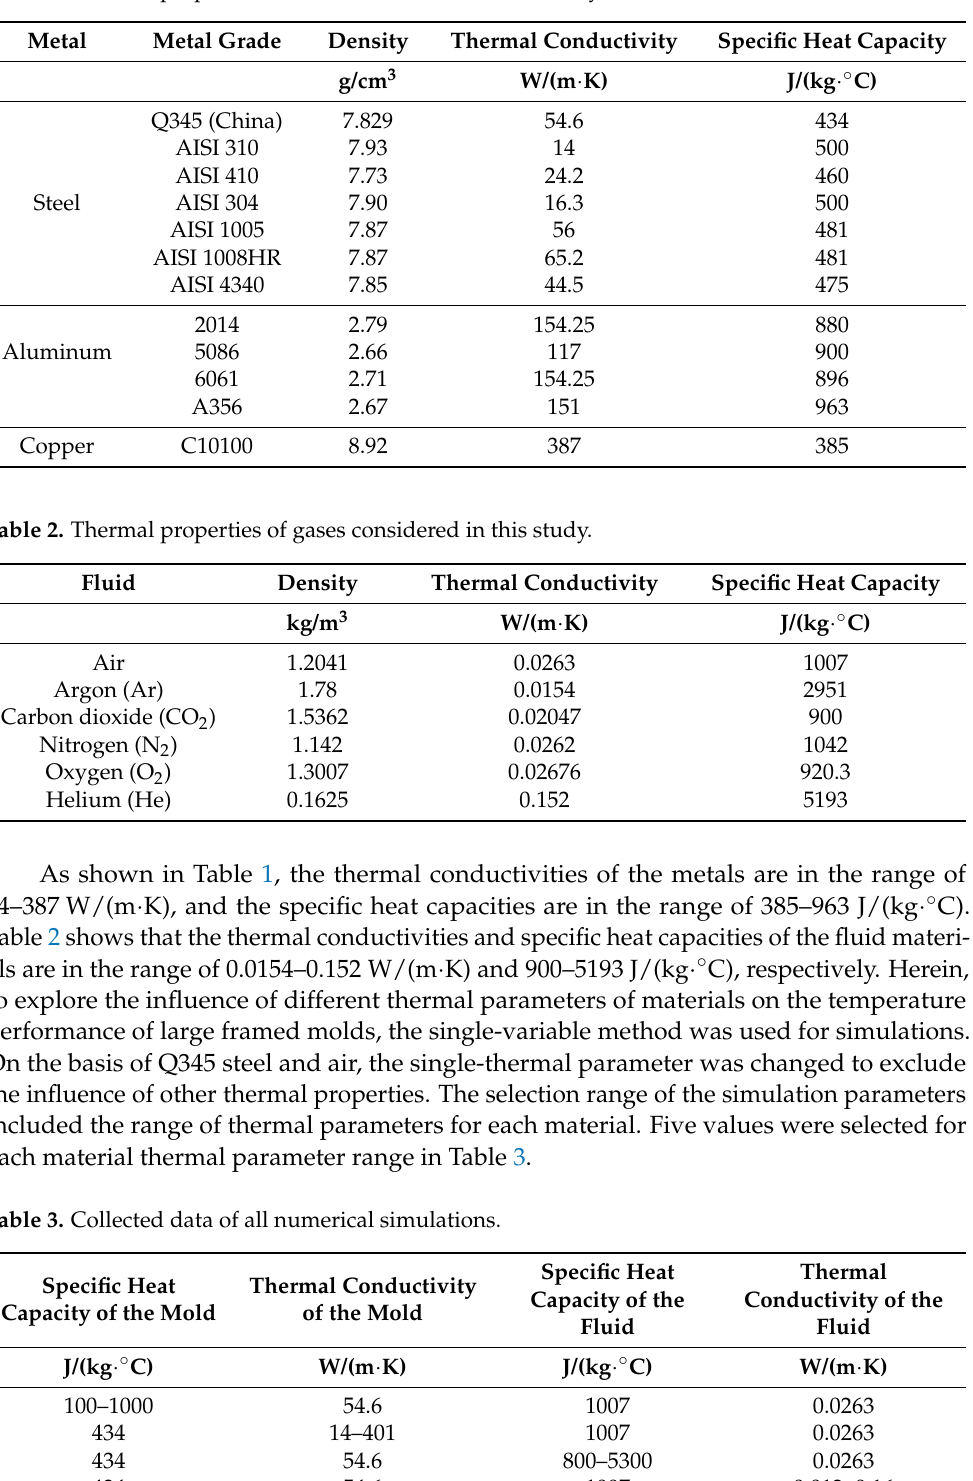
Table 1. Thermal properties of metals considered in this study.